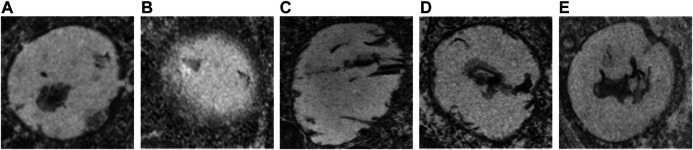
TEM micrograms. Representative cerebral microvascular ultrastructures (x 10,000). (A) DM sham group, (B) DMCI group, (C) FYXN group, (D) Nim & Met group and (E) NC group. An intact cerebral microvascular ultrastructure is shown in DM sham and NC groups, and a disordered cerebral microvascular ultrastructure is illustrated in DMCI, FYXN and Nim & Met groups. Scale bars = 200 nm.